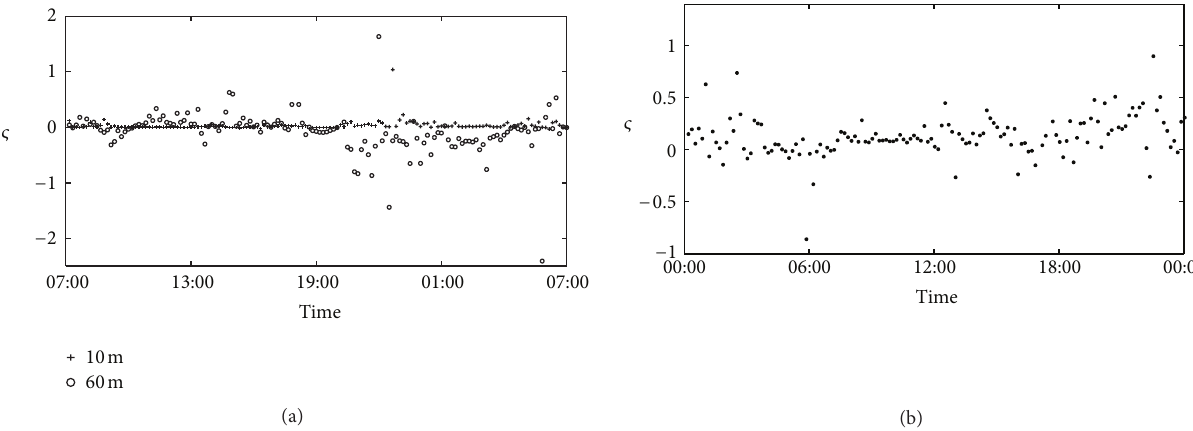
Figure 6: Atmospheric stability during strong typhoons: (a) typhoon Nuri from 00:00 am on August 22 to 23:59 pm on August 23, 2008, at 10m and 60m height and (b) typhoon Hagupit from 0:00 am to 23:59 pm on September 24, 2008, at 60m height.